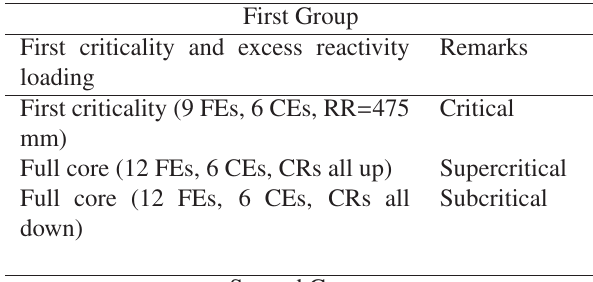
Table 1. Design Parameters of RSG GAS [3]